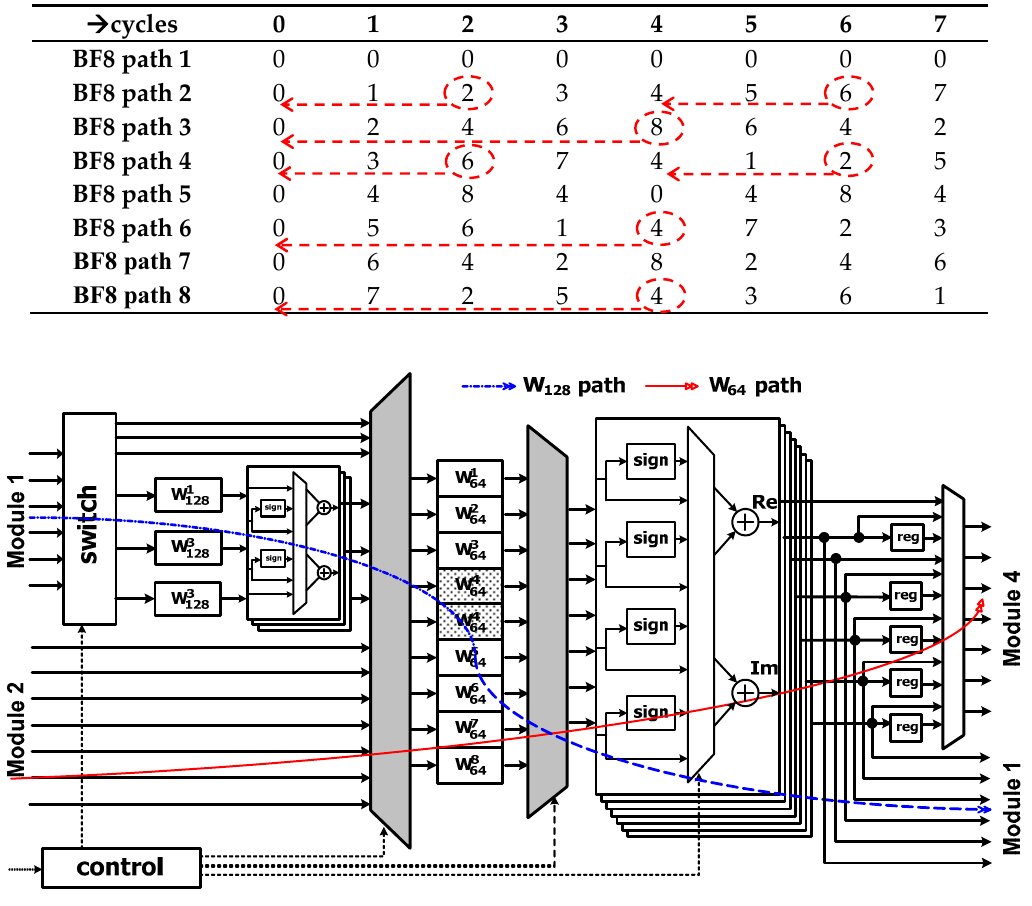
Figure 13. Block diagram of Module 3 (CMU).